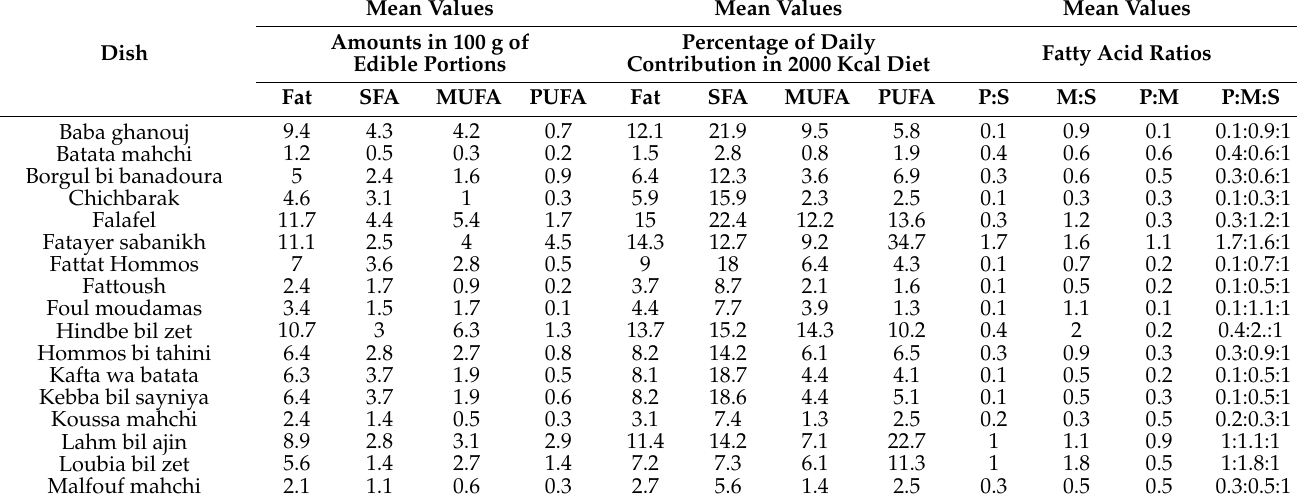
Table 1. Fatty acid ratios and total fatty acid mean values in 100 g of edible portions of traditional dishes and the percentage of their daily contribution in a 2000